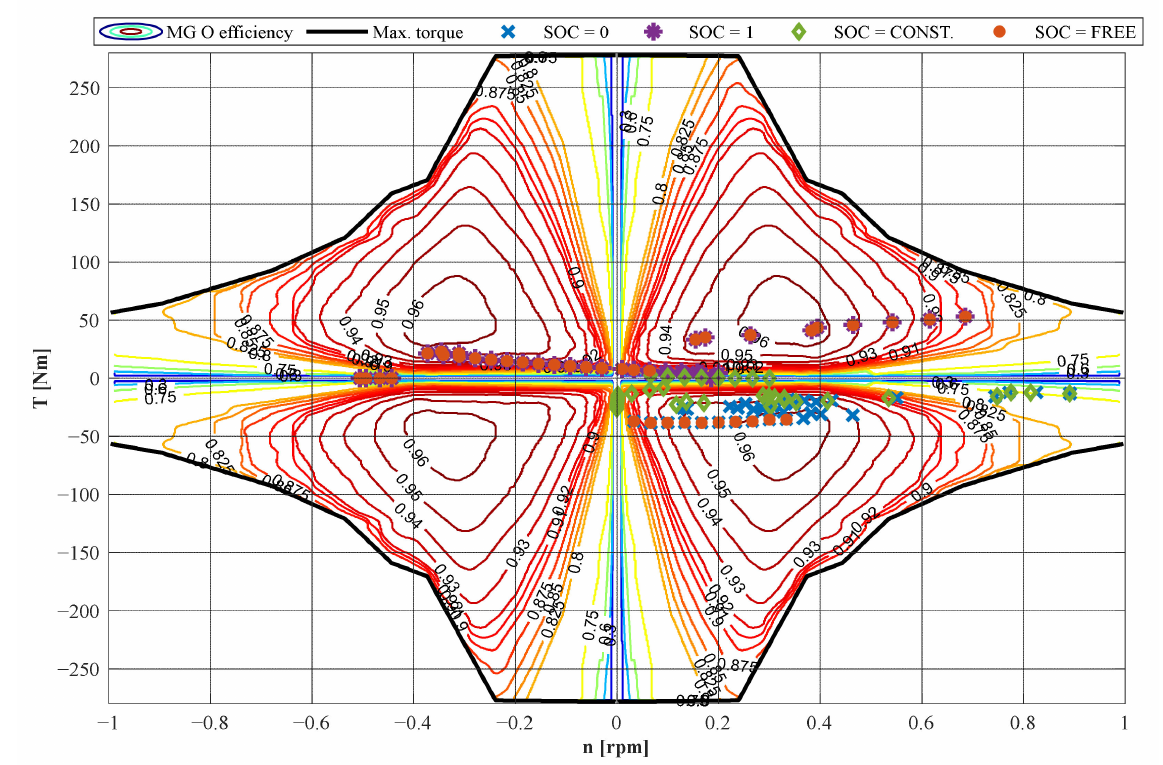
Figure 9. MG O optimal functioning points in power-split operation.